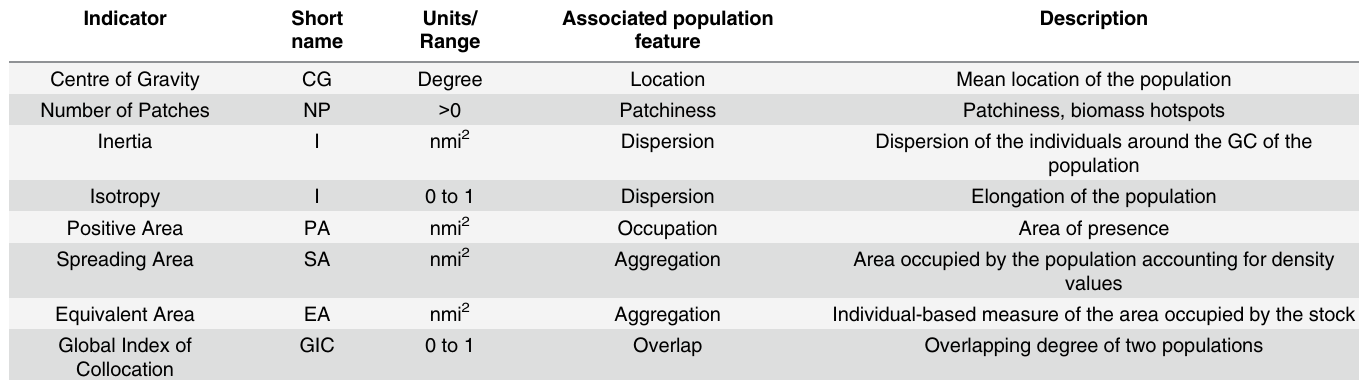
Table 1. Summary of the spatial indices (based on [3]) used to characterize the spatial pattern of anchovy and sardine